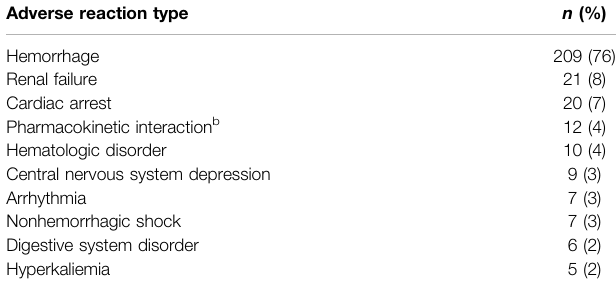
TABLE 6 | ADR 10 most frequent types among fatal cases, n (cid:1) 274 a